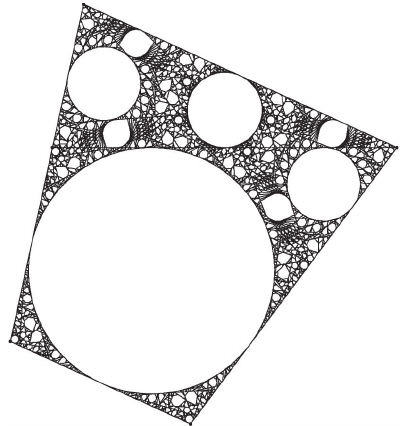
𝜌 = 1 Figure 3: The illustration to invariant disk packing induced by the map (17), where the parameter 𝜃 = 1.78 . We can observe that all the periodic disks are